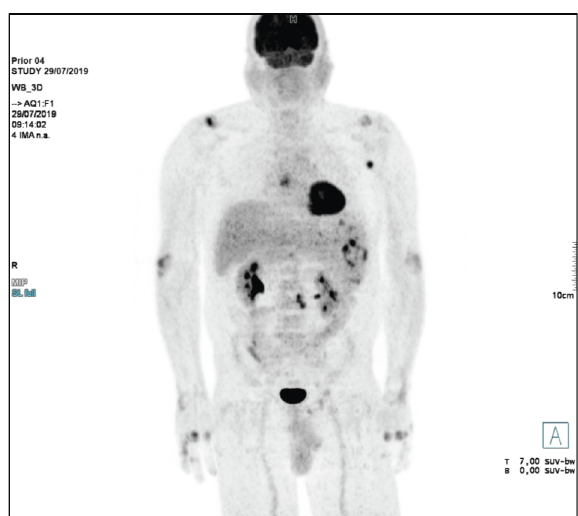
Figure 2: 18F-FDG PET/CT performed four months after MTX discontinuation, showing a reduction of the hypermetabolic activity of spleen and lymph nodes, and a spontaneous resolution of the hypermetabolic involvement of lungs and bone marrow.